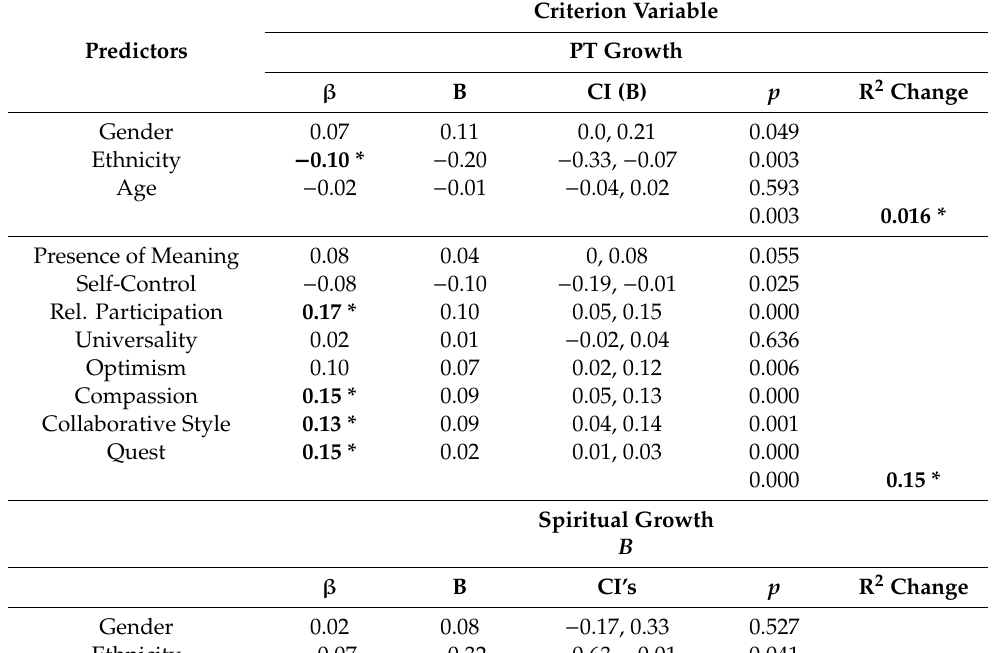
Table 3. Multiple Hierarchical Regressions by Criterion